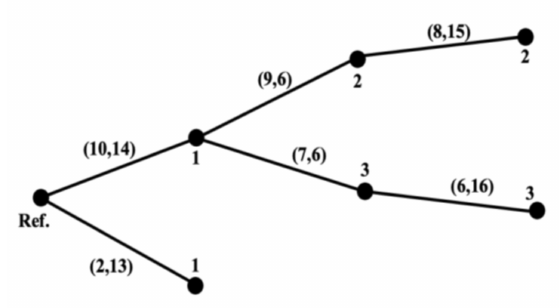
Figure 4. Dependency tree of the illustrative example for node